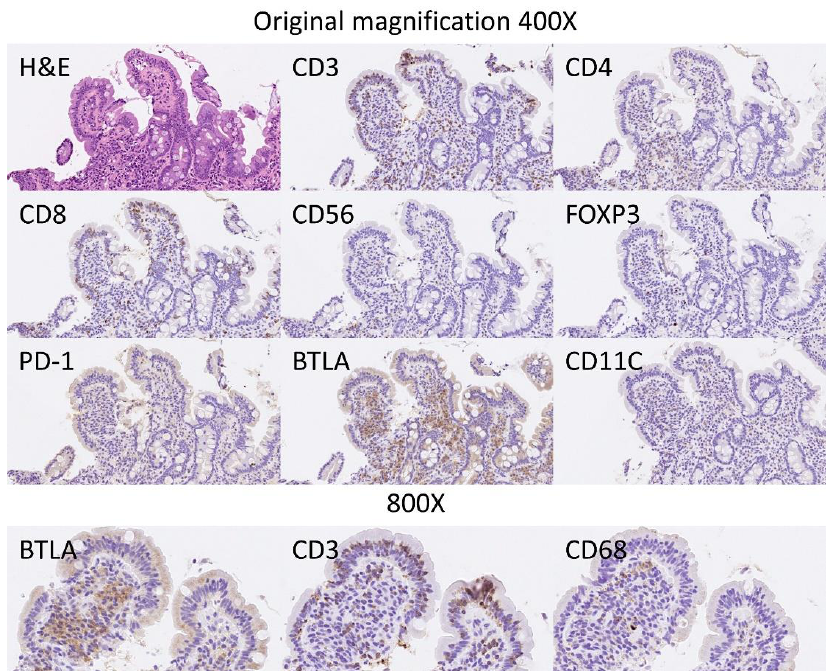
Figure 7. BTLA protein expression by immunohistochemistry in the validation series. After BTLA immunohistochemistry and quantification, celiac disease cases were characterized by high BTLA protein expression ( p < 0.001). The outliers are marked with a circle, next to the icon there is a num- ber that corresponds to the case number.